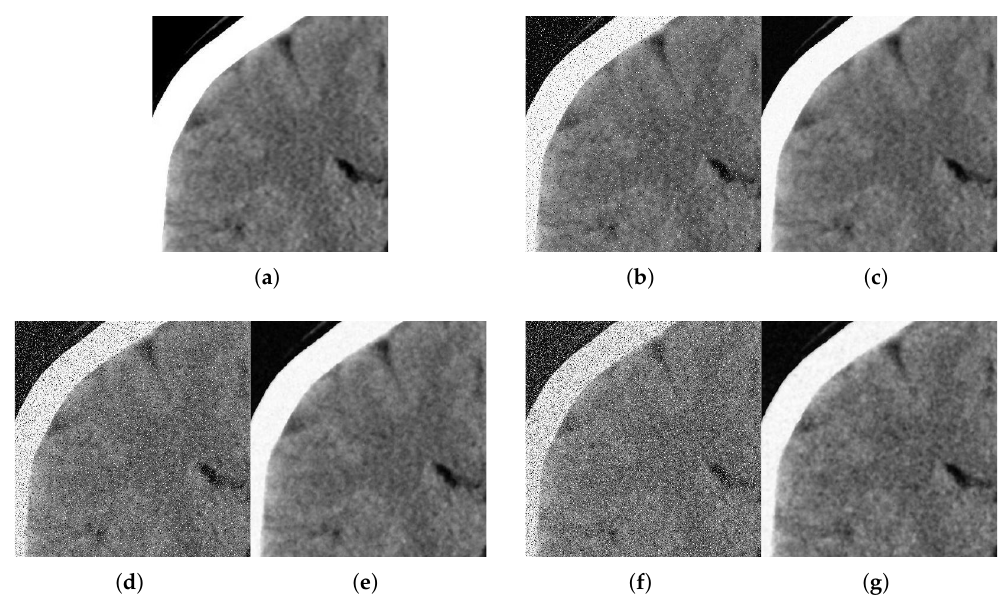
Figure 11. Method outputs. Coronal view corrupted with impulsive noise p and Gaussian σ . ( a ) Original coronal. ( b ) Noisy p = 0.1, σ = 10. ( c ) Method output. ( d ) Noisy p = 0.2, σ = 20. ( e ) Method output. ( f ) Noisy p = 0.3, σ = 30. ( g ) Method output.